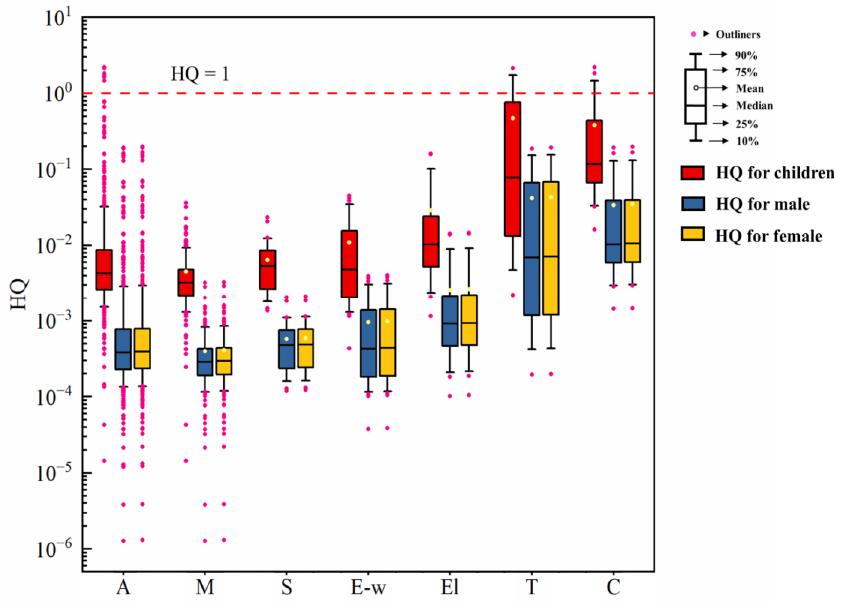
Figure 4. The non-carcinogenic risk of all the collected regions and for different region types. (A: all the collected regions; M: mining areas; S: heavy metal processing and smelting areas; E-w: E-waste treatment and disposal sites; El: electroplating sites; T: tanning and the tannery sludge storage sites; C: Cr salt production and chromite ore processing residue disposal